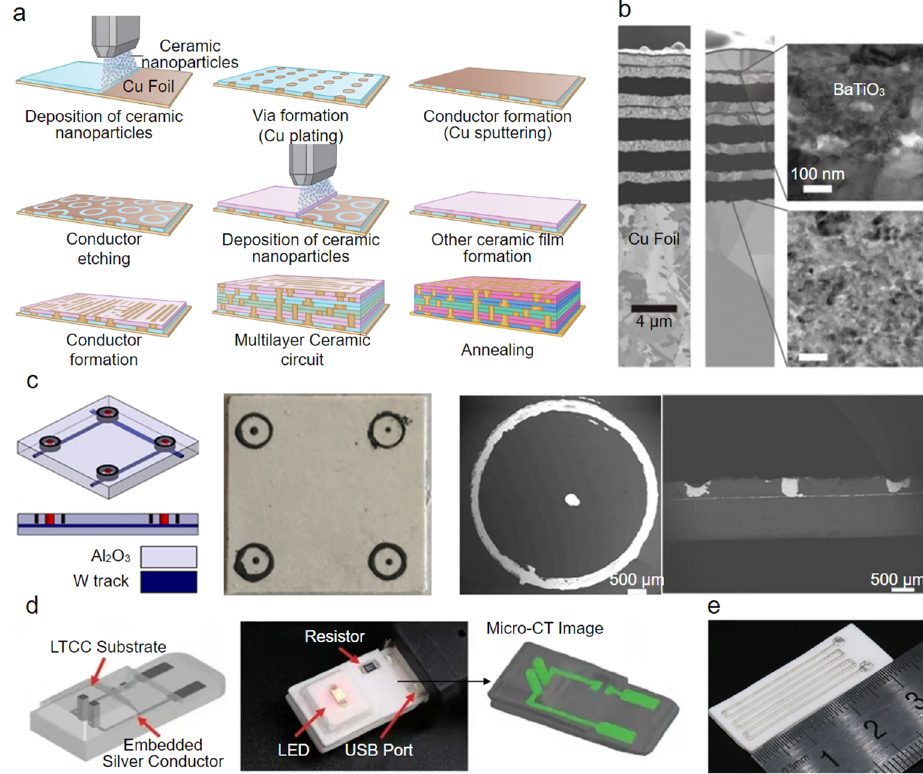
Figure 10. Multi-material 3D-printed multilayer ceramic substrates. ( a ) Schematic illustration of the hybrid multi-material integration process combining aerosol jet printing, chemical etching, sputtering, and plating techniques [190]. ( b ) SEM image of the fabricated mesoscale multilayer ceramic structure with fine copper electrodes and vias [190]. ( c ) Schematic illustration of the design concept for the HTCC structures ( left ) and photograph of the multi-material 3D-printed HTCC structure (middle) and its SEM image ( right ) [191]. ( d ) Schematic illustration of the design concept of the multilayer ceramic substrate for a LED ( left ) and photograph of the multi-material 3D-printed multilayer ceramic substrate in a working condition ( middle ) and its micro-CT image ( right ) [22]. ( e ) Photograph of a multi-material 3D-printed ceramic thermometer [22].